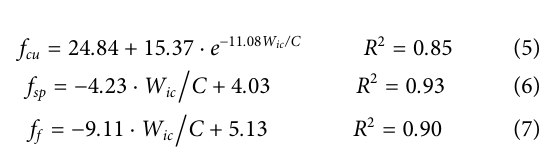
Frontiers in Materials |